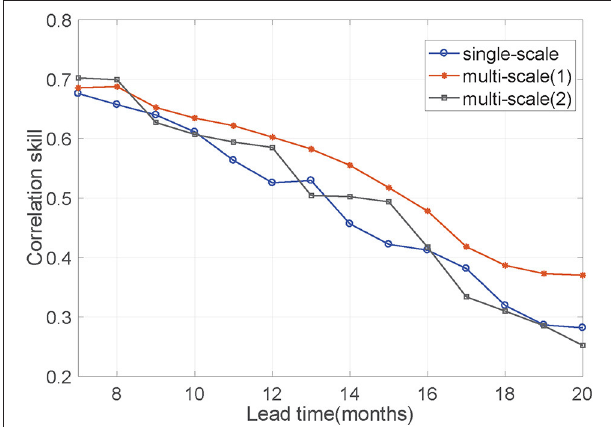
FIGURE 6 | The Corr between predicted values and actual values with different relationships among lead months, input mesh size, and convolution kernel size. Their relationship determines the ratio of the receptive field size in the three prediction lead terms. Single-scale means that input mesh size and convolution kernel size are the same with the increase of lead months. The Conv3d are A/C/E (8,4), B/D/F (4,2) at MSC module. Thus, the receptive field size about these three terms has a ratio of 1:1:1. Multi scale(1) means their relationship is consistent with Equation (6). Noticeably, these three terms correspond to the different input mesh size by downsampling the original map and the ratio of input mesh size is 1:4:16. The Conv3d are different at MSC module, is A(8,4)/B(4,2),C/D (4,2), E/F (2,1). So the receptive field size about these three terms has an approximate ratio of 1:2.5:4. Multi scale(2) have the same input mesh size as multi scale(1) in these three lead terms. But multi scale(2) uses the same Conv3d (A/C/E (8,4), B/D/F (4,2)) at MSC module, so the relationship is not consistent with Equation (6). The size of the receptive field about these three terms has a ratio of 1:4:16.